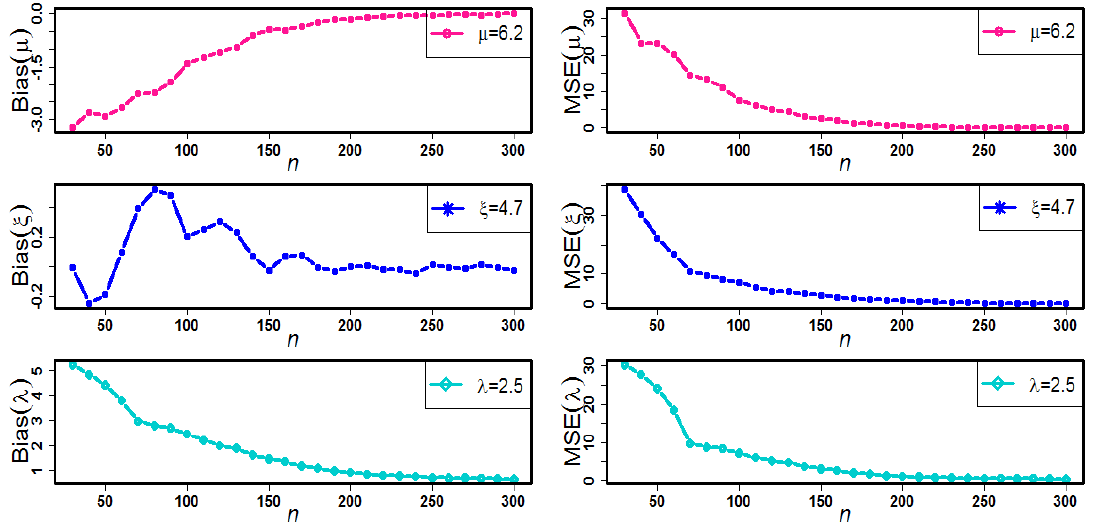
Figure 5. The performance of bias and MSE profiles against ˇ µ , ˇ ξ and ˇ λ for set-II.